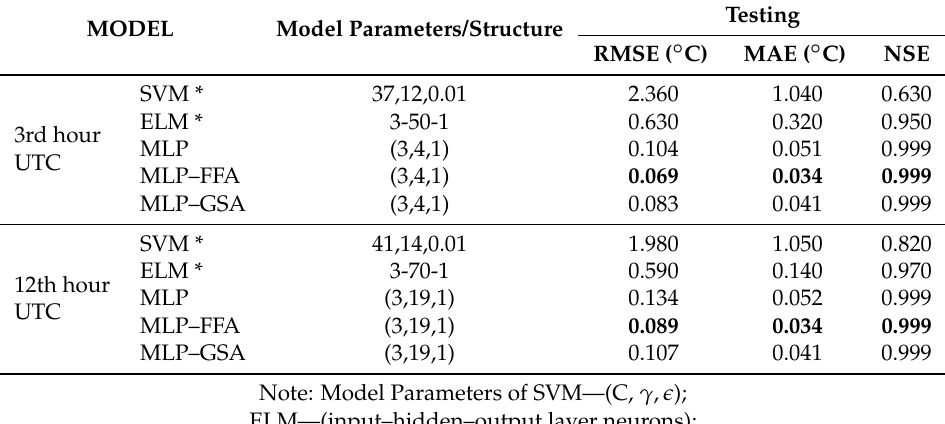
Table 5. The performance of the computed metrics for Hyderabad